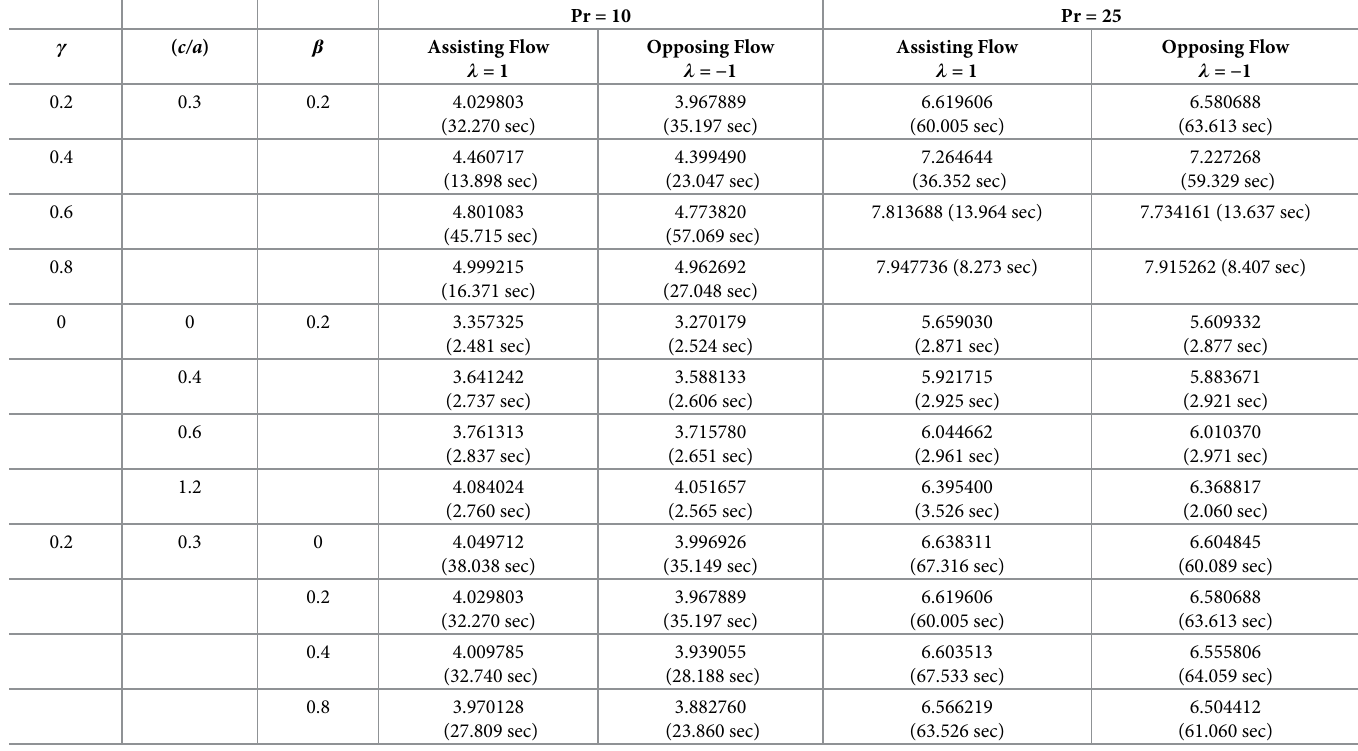
Table 4. Computational results of − θ 0 (0) for varying values of γ ,( c / a )and β with M = 5.